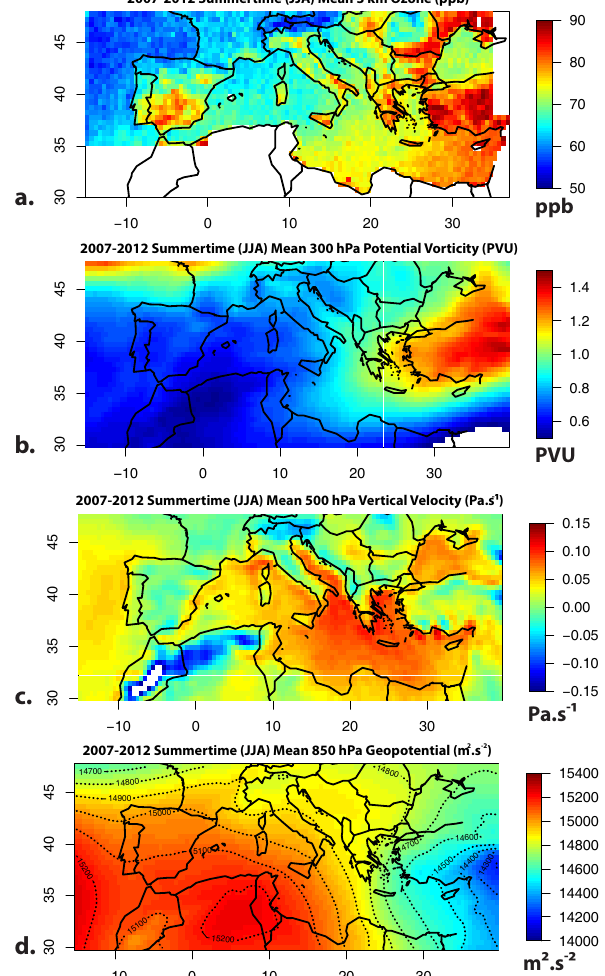
Figure 3. 2007–2012 summertime (June, July and August) aver- age of ozone measured by IASI (morning overpasses) and mete- orological variables taken from 12h ERA-Interim reanalysis: (a) 3km ozone concentration (ppb); (b) 300hPa potential vorticity (PVU); (c) 500hPa vertical velocity (Pas − 1 ); (d) 850hPa geopo- tential (m 2 s − 2